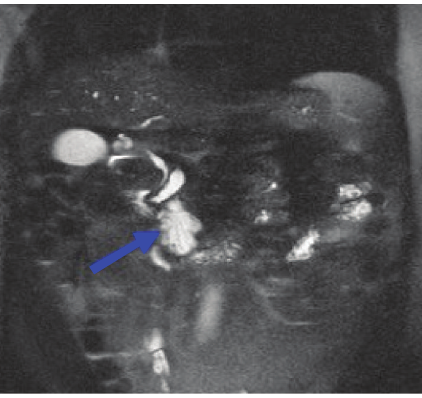
Figure 2: MRCP Coronal HASTE 2D. The scan shows the fusiform dilatation of the Wirsung duct at the head of the pancreas and the cystic lesion. The blue arrow indicates the